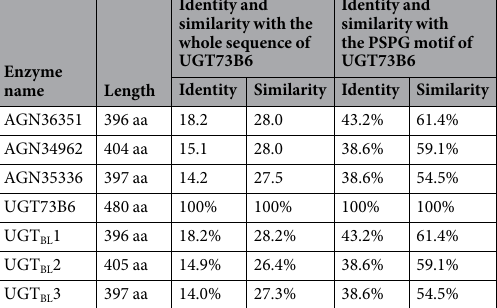
Table 1. Glycosyltransferase from Bacillus licheniformis ZSP01 compared with UGT73B6 from Rhodiola sachalinensis .